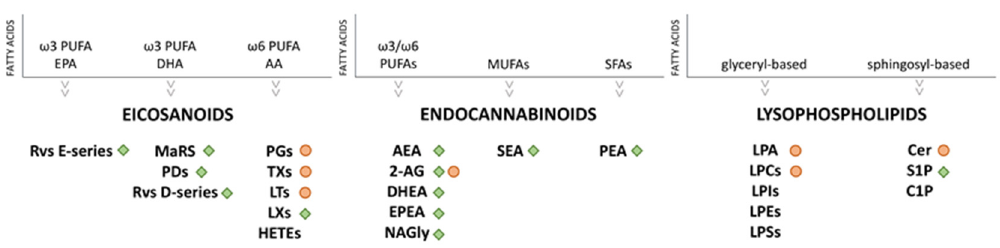
Figure 1. Lipids involved in inflammation. The green squares indicate lipids with anti-inflammatory properties and the orange dots indicate lipids with pro-inflammatory properties. Abbreviations. PUFAs: polyunsaturated fatty acids;